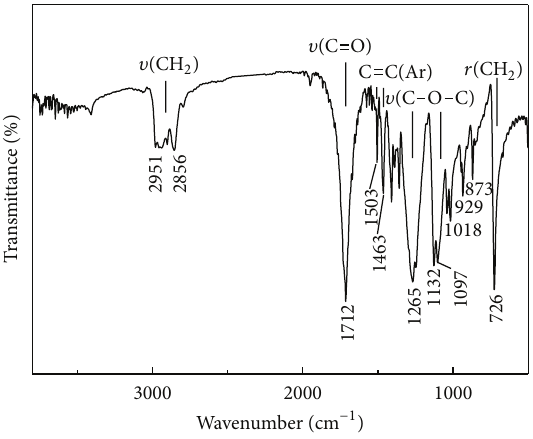
Figure 1: FTIR spectra of PTT-PTMG copolymer.